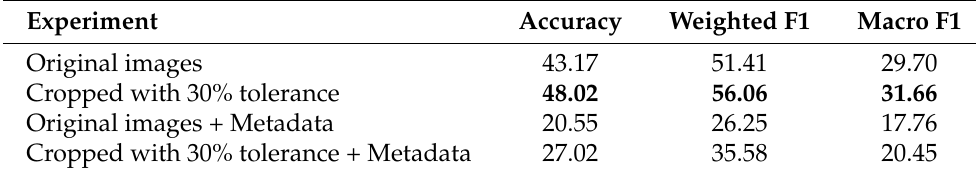
Table 9. Metrics score of test set 1 for prioritization approaches (in %).